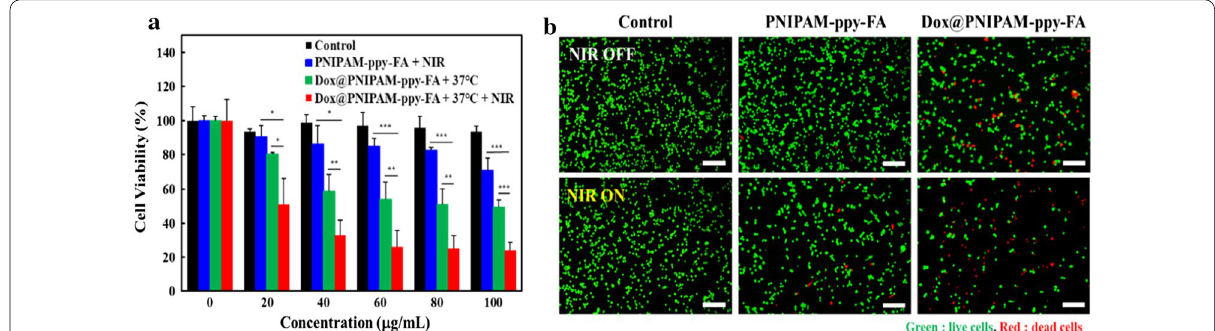
Fig. 5 a Quantitative analysis of viability of MDA-MB-231 breast cancer cells treated with PNIPAM-ppy-FA and Dox@PNIPAM-ppy-FA with different concentrations and with or without 808 nm NIR laser irradiation. b Fluorescence images of live/dead assay in MDA-MB-231 cells after treatment of PNIPAM-ppy-FA and Dox@PNIPAM-ppy-FA nanocomposites (60 μg/mL) with or without NIR laser irradiation. The live and dead cells are stained with Calcein AM (green) and Ethidium homodimer-1 (red). Scale bars are 200